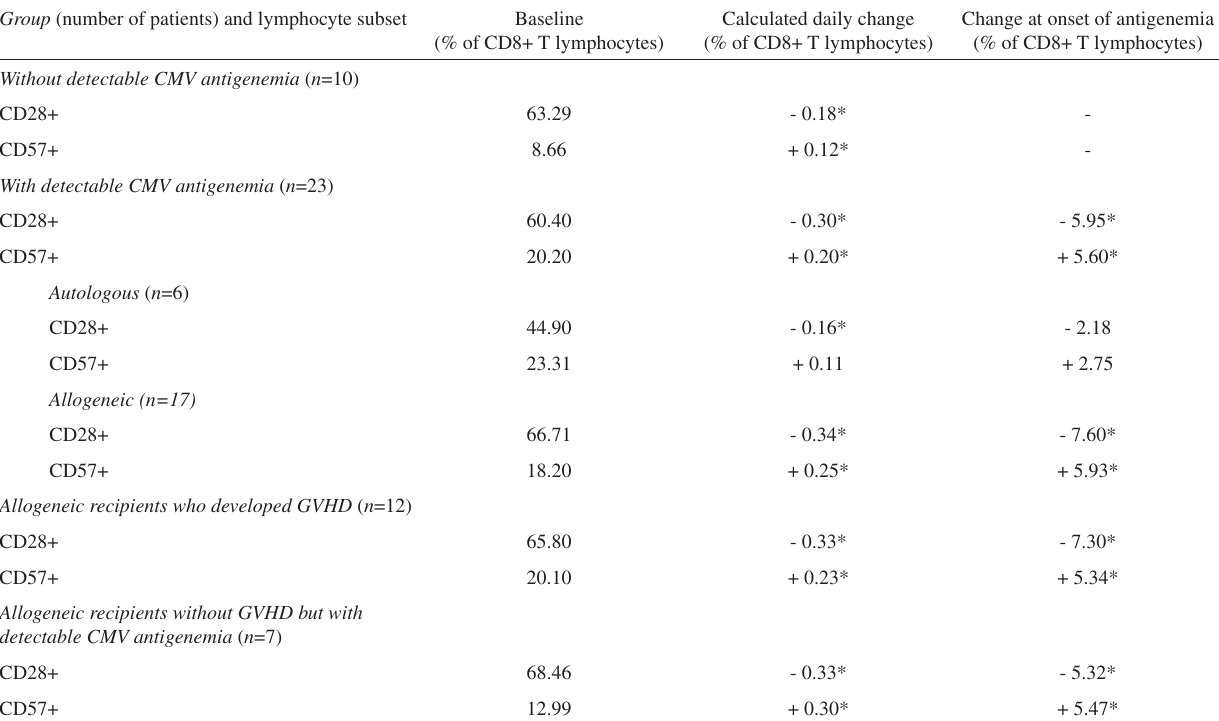
Group (number of patients) and lymphocyte subset Baseline